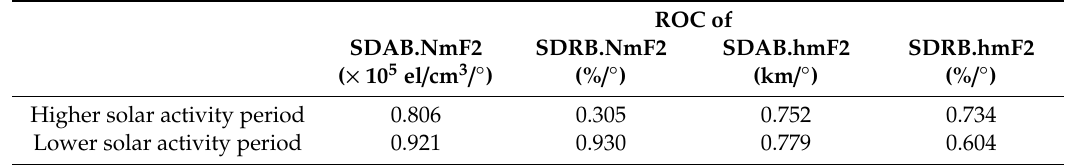
Table 3. The rate of change (ROC) of SDABs and SDRBs with the variations of SEAs for the comparison between FY-3C RO-derived ICPs and the digisondes-derived ones. ROC of SDAB.NmF2 ( × 10 5 el / cm 3 / ◦ ) Higher solar activity period Lower solar activity